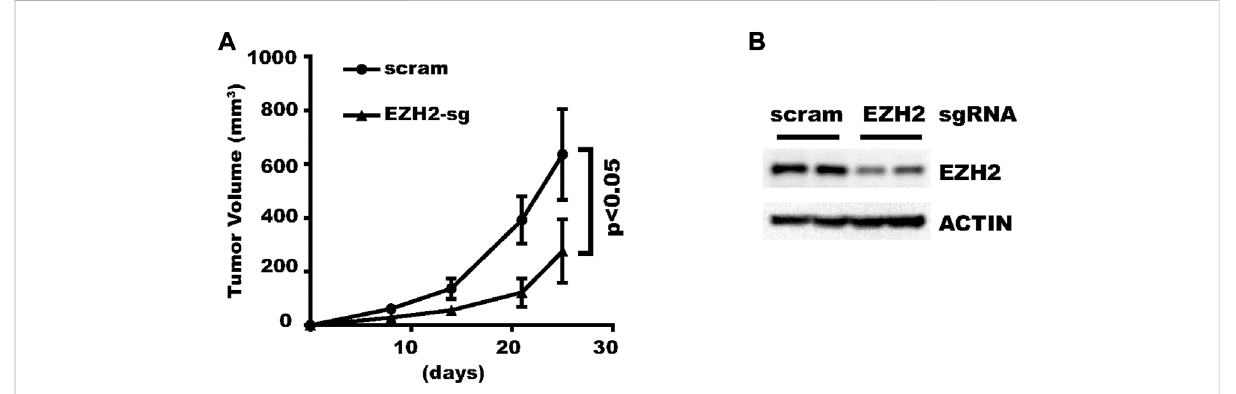
Genes can be ef fi ciently knocked-down in vivo . HLF cells expressing EZH2-sgRNA or control vector was inoculated subcutaneously into nude mice. Geneknock-down wasinduced withDoxycyclineindrinkingwater. (A) Growth curveofthexenograft tumors. (B) Western Blotresultsforfour representative